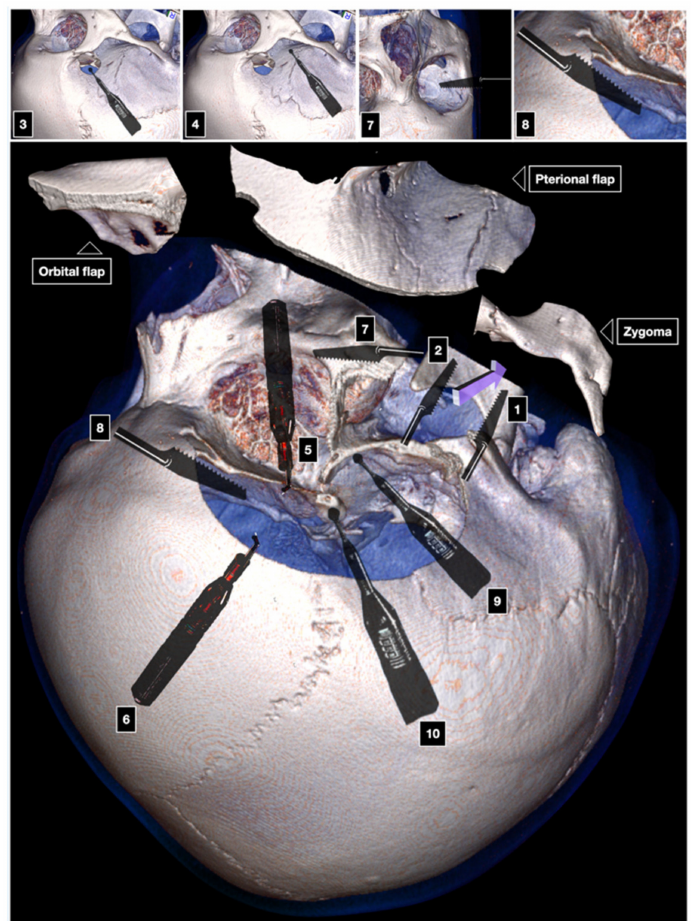
Figure 6. Three-piece COZ approach. 1: first cut; 2: second cut; 3: McCarty keyhole; 4: connection of the McCarty keyhole with the inferior orbital fissure; 5: elevation of the pterional bone flap; 6–8: supero-lateral orbitotomy; 9: drilling of the temporal squama; 10: anterior